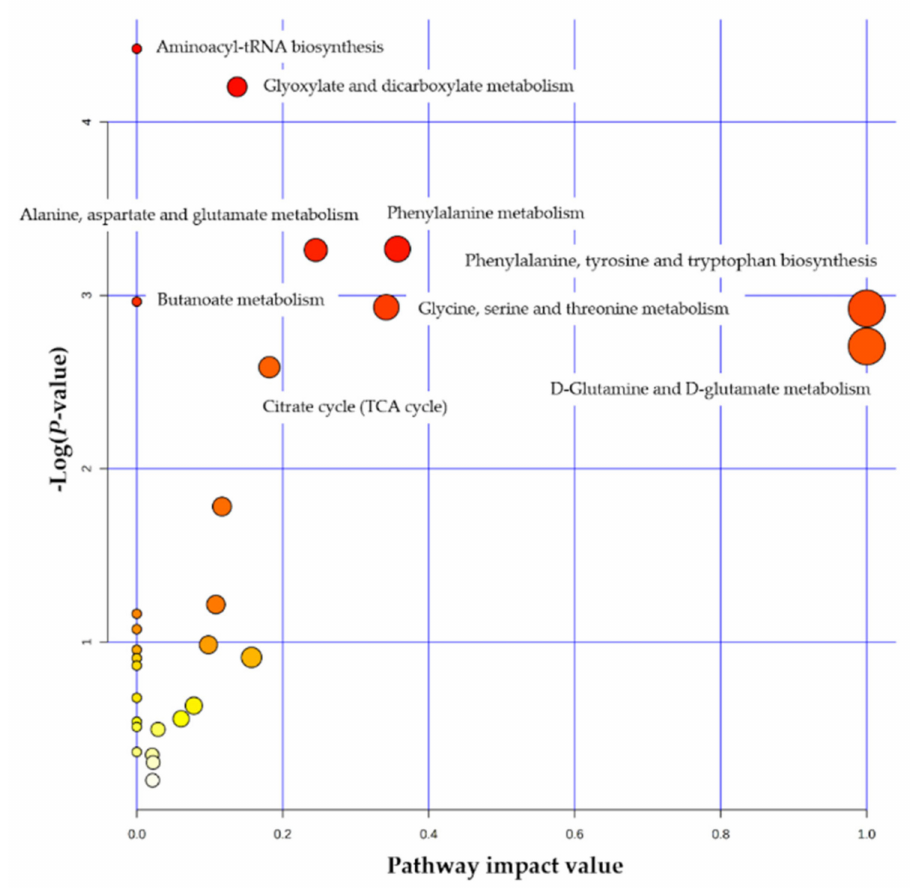
Figure 1. Pathway analysis for the metabolites associated with feed efficiency using Bos taurus as the library. Note: the pathway impact value is calculated using the sum of importance measures of the matched metabolites divided by the sum of the importance measures of all metabolites. The sizes and colors of the circles indicate the matched metabolite ratio and the log ( p -value) of each pathway,